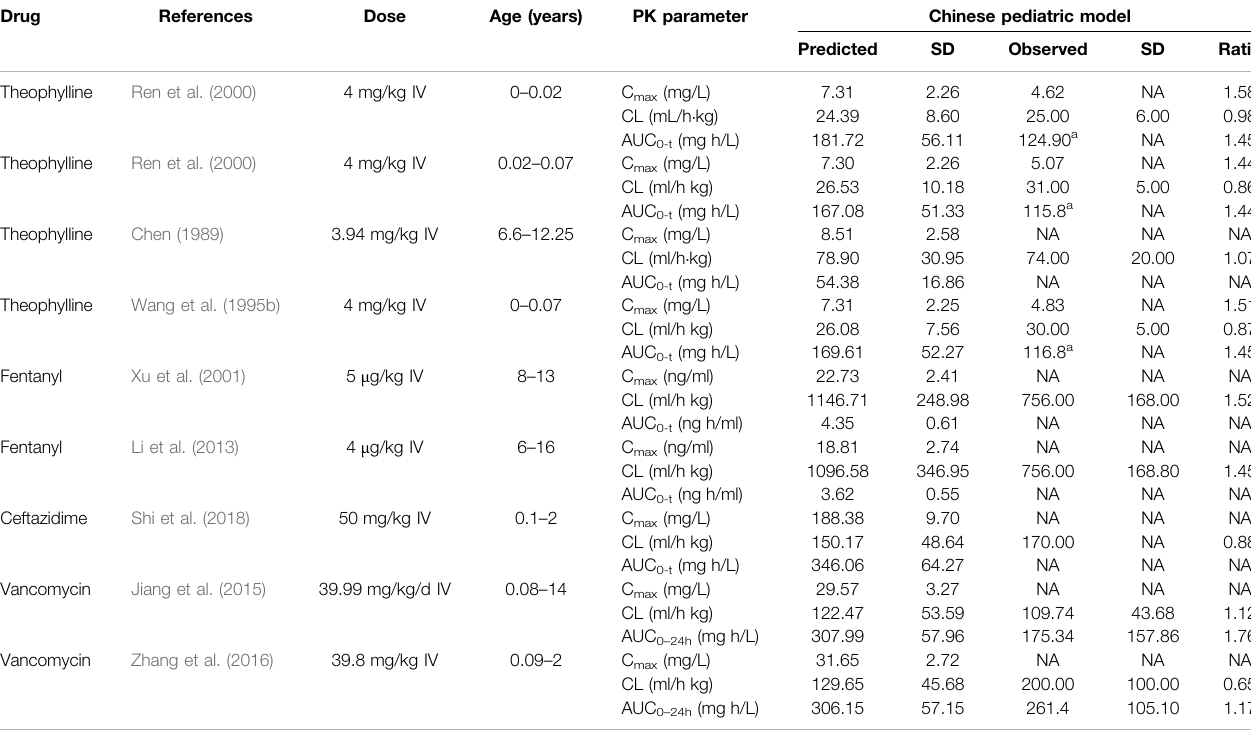
TABLE 4 | PK parameters of probe drugs predicted by CN pediatric model in Chinese pediatric population.